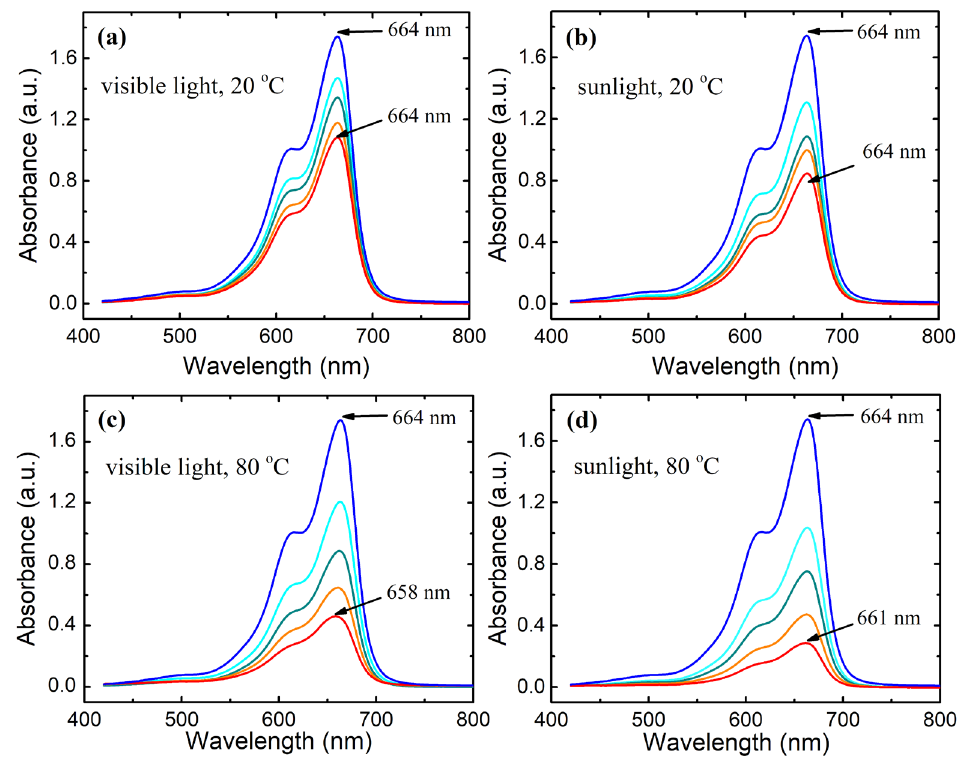
Figure 3. Absorption spectra of MB aqueous solution with a concentration of 10 mg·L −1 under visible light and sunlight illumination at temperatures of 20 and 80 °C for 120 min. Lighting time from upper blue curve to lower red curve: 0, 30, 60, 90, and 120 min. ( a ) illumination by visible light at 20 °C; ( b ) illumination by sunlight at 20 °C; ( c ) illumination by visible light at 80 °C; ( d ) illumination by sunlight at 80 °C.